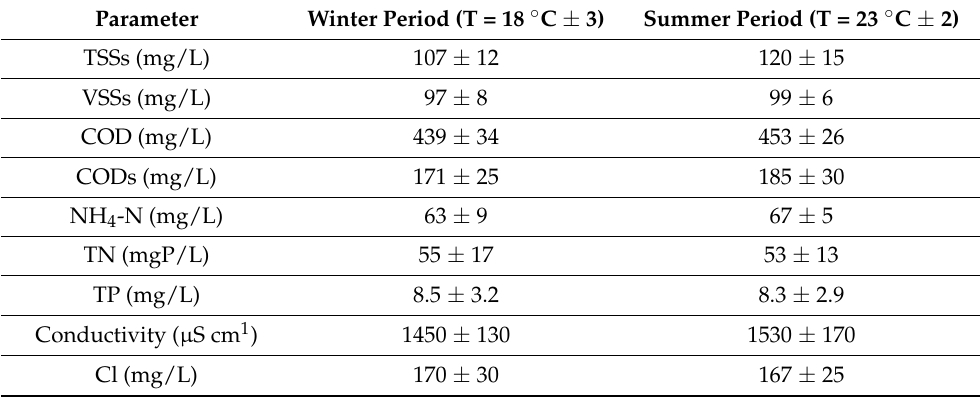
Table 1. Characteristics of the inlet screened municipal wastewater.